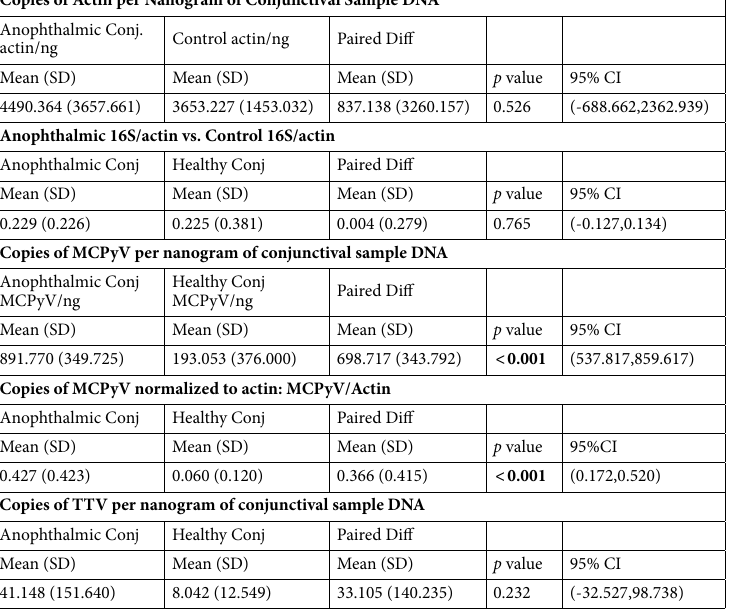
Table 4. Quantitative PCR in anophthalmic and contralateral